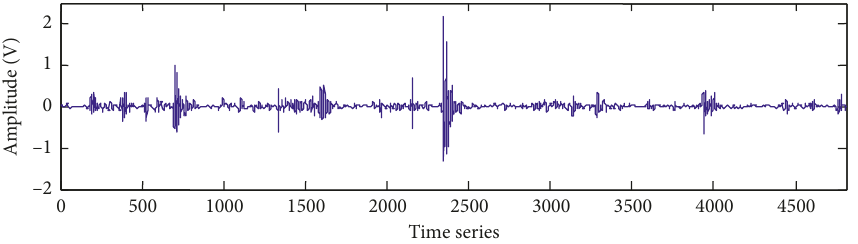
Figure 14: A preprocessed vibration signal.